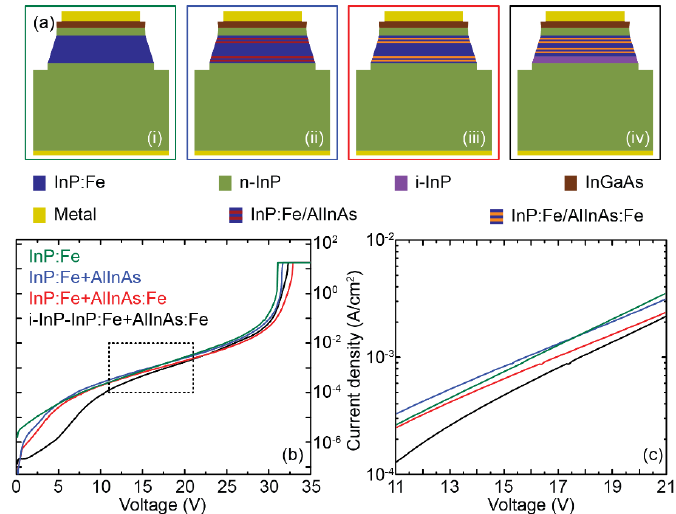
Figure 5. Summary of leakage optimization in the lateral regrowth. ( a ) Schematic drawings of the different test structures; ( b ) summary of I-V profile measurements from different test structures depicted in ( a ); and ( c ) a zoomed version of ( b ), focusing on the operation voltage region of mid-infrared QCLs, indicated in ( b ) by the dashed box.